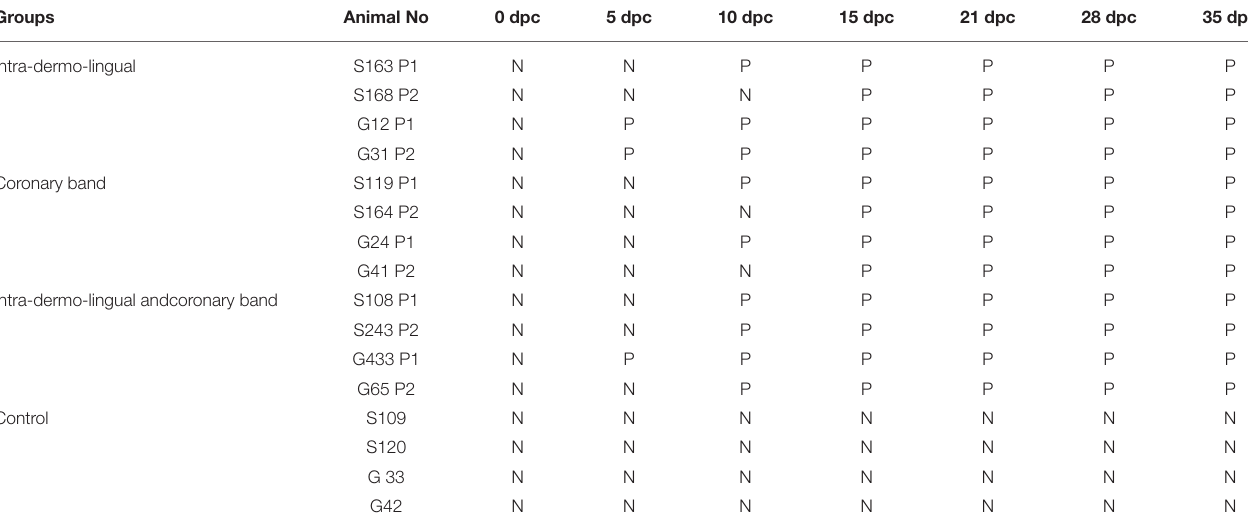
TABLE 3 | FMDV NSP antibody responses of challenged and control sheep and goats. Groups Animal No 0 dpc Intra-dermo-lingual S163 P1